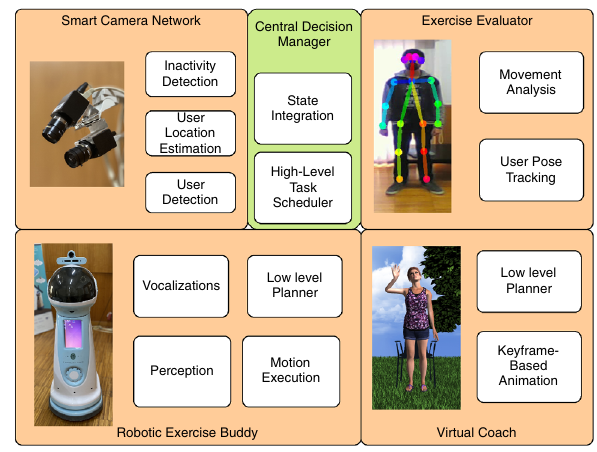
Fig. 5 Architecture composed by a centralised decision making agent and four main distributed execution